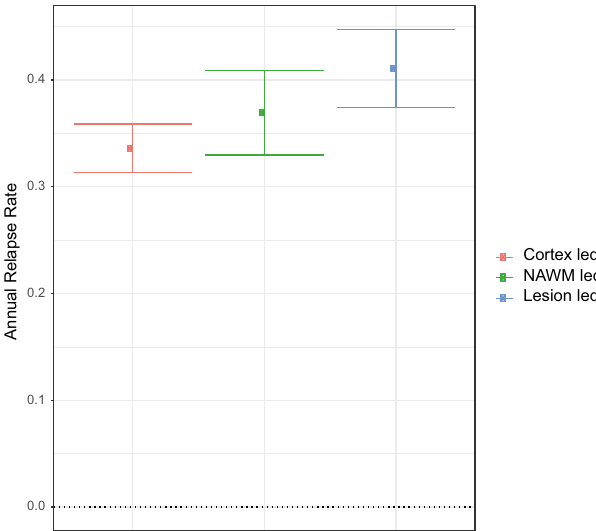
Fig. 4 MRI-based subtypes predicted disease activity in the placebo arms of the validation dataset. The average annual relapse rate for each MRI- based subtype. The centre shows the estimated average of annual relapse rate and error bars represent the standard error. The lesion-led subtype had signi fi cantly higher annual relapse rate than the cortex-led subtype ( n = 1663 patients).